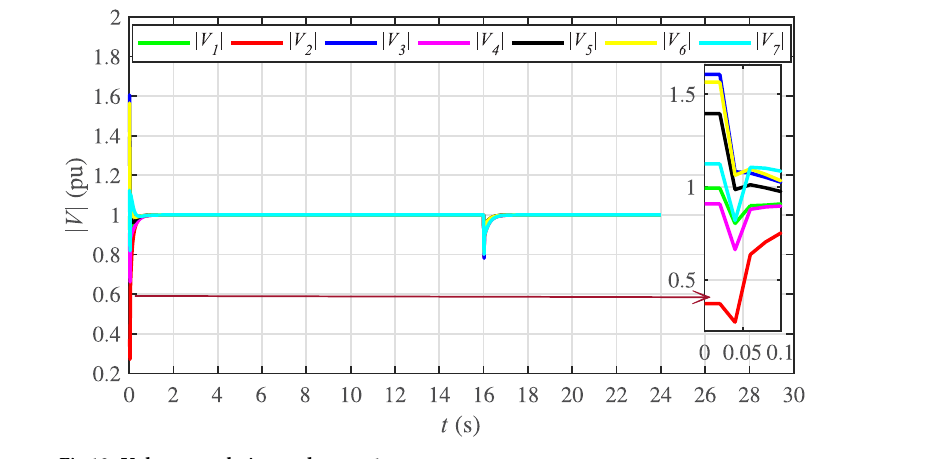
Fig 13. Voltage regulation under case 1.